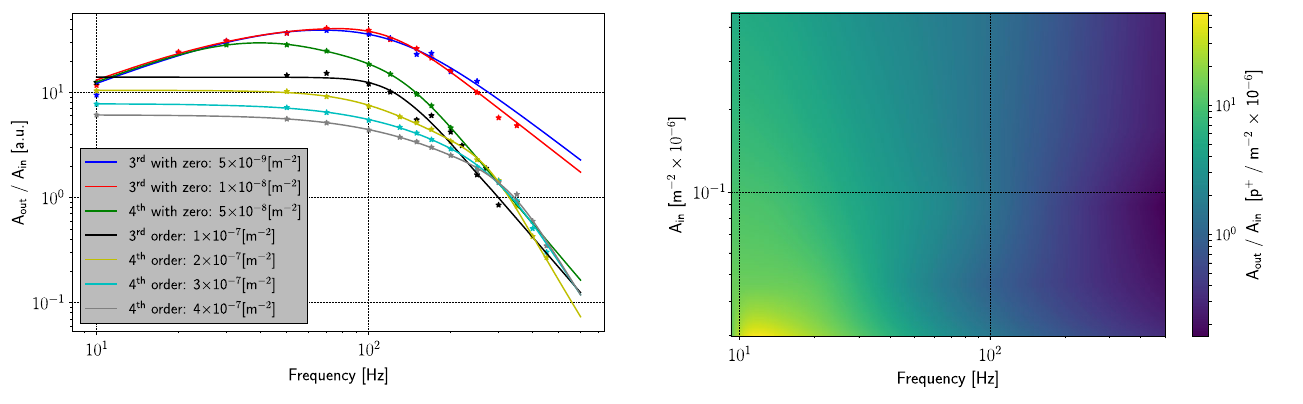
FIG. 9. Fixed amplitude transfer functions fitted with curves of the type of Eq. (8). The legend refers to the order of the low-pass filter which gives the best fit.